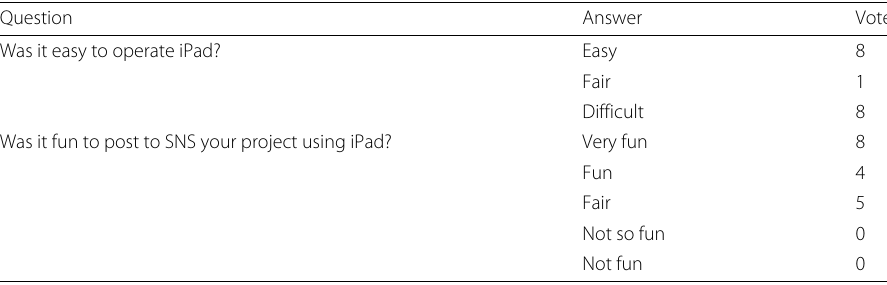
Table 4 Questions on usability of the SNS Question